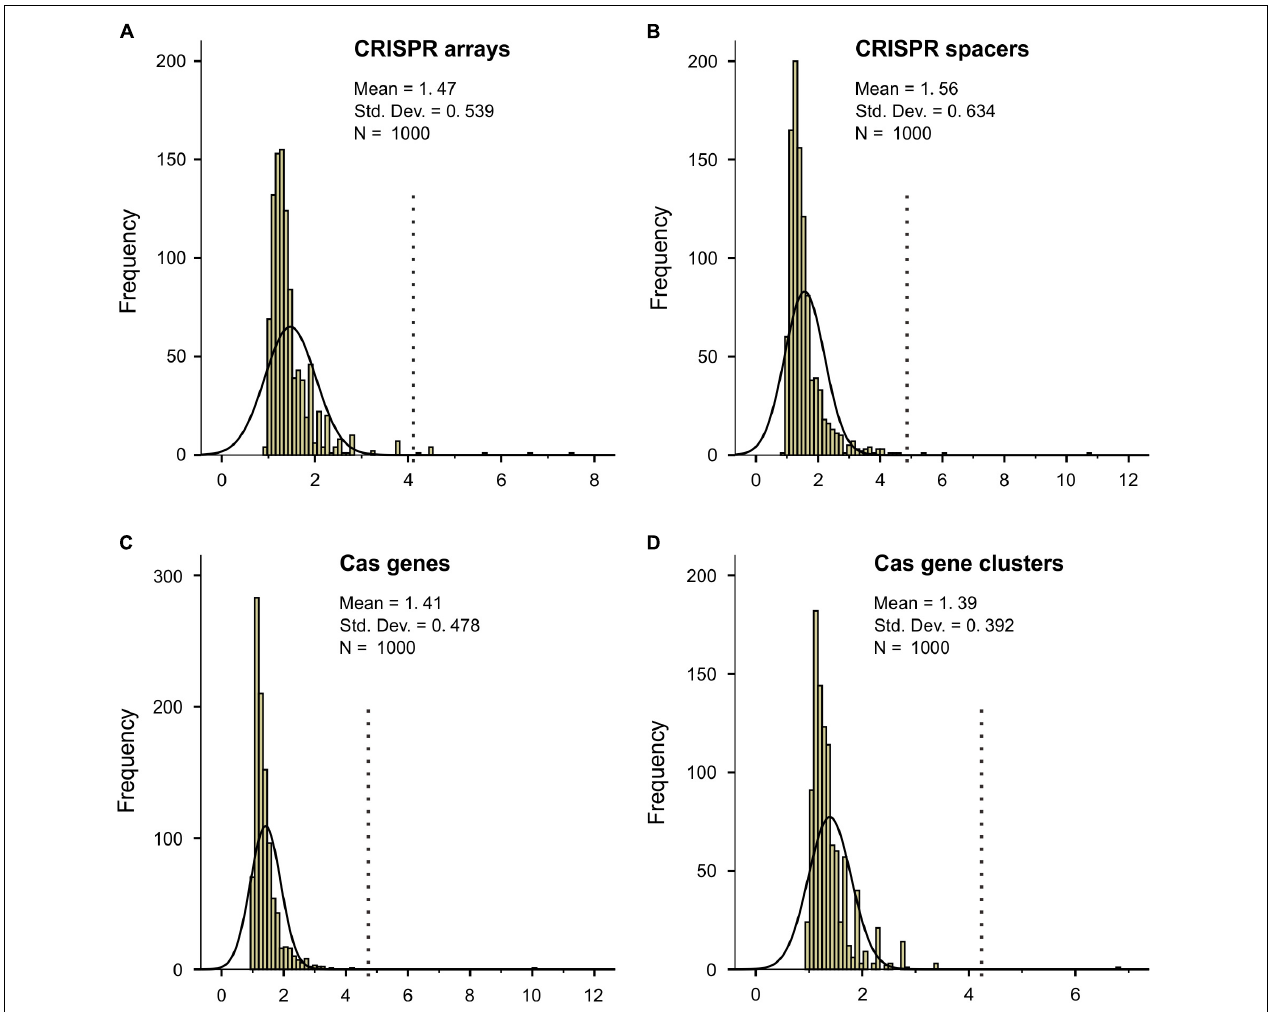
FIGURE 2 | Permutation tests for the separate distribution of CRISPR-Cas poor and CRISPR-Cas rich bacteria along the temperature axis. The null hypothesis is that the bacteria were randomly distributed within the studied temperature range. The ratio of average CRISPR-Cas abundance at equal and above a temperature divided by that below the temperature was defined as D i . The maximum values of D i for the observed results (indicated by the dotted lines) and the 1000 rounds of random shuffling of CRISPR arrays, spacers, cas genes, and cas gene clusters were shown in (A–D)